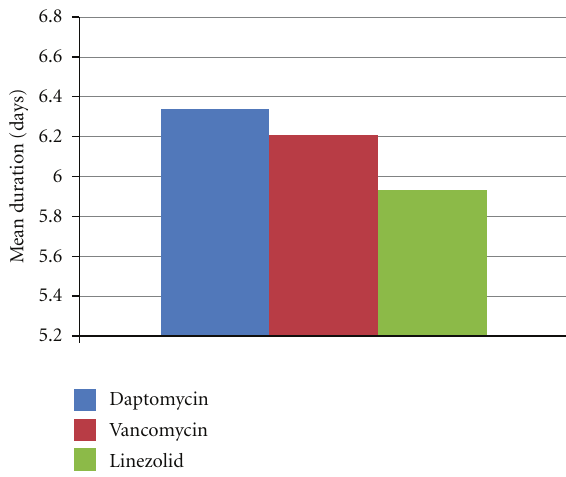
Figure 1: Mean duration of antibiotic therapy.